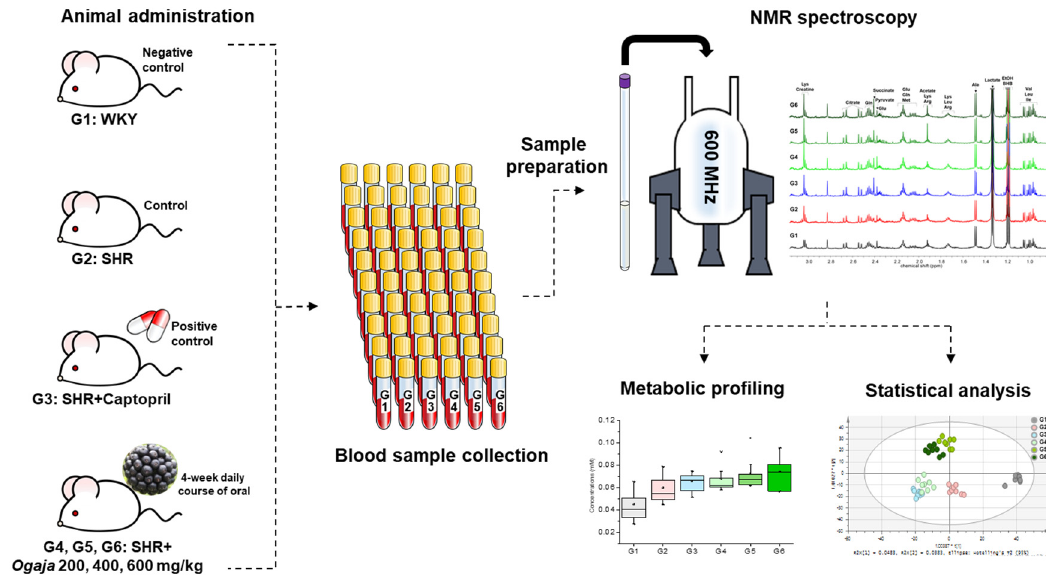
Figure 1. Overall experimental scheme of nuclear magnetic resonance (NMR)-based metabonomics for antihypertensive effects of Acanthopanax sessiliflorus fruits (Ogaja) on spontaneously hypertensive rats